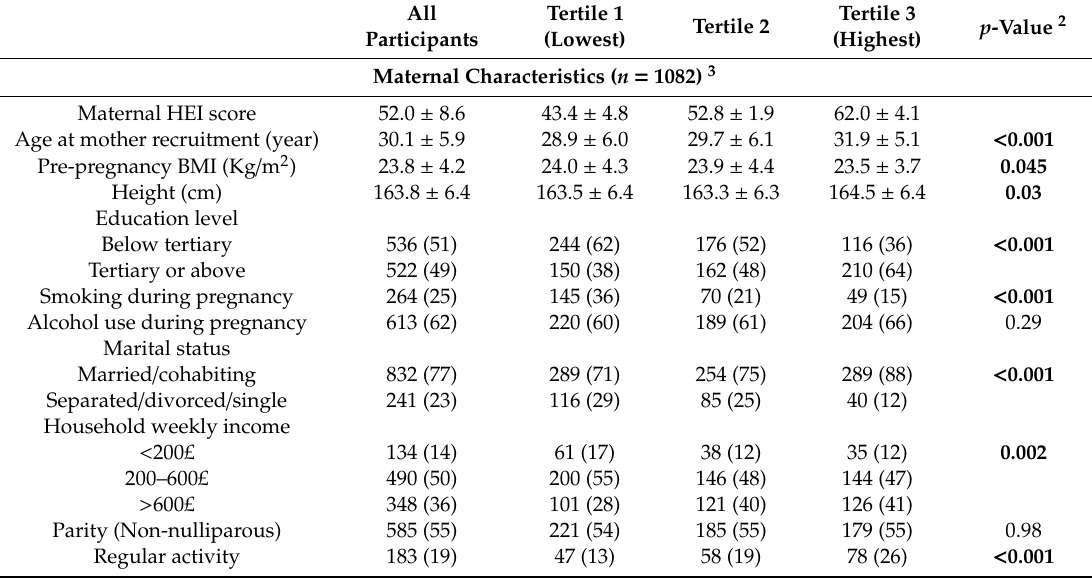
Table 1. Characteristics of the study participants according to parental tertiles of healthy eating index (HEI) scores 1